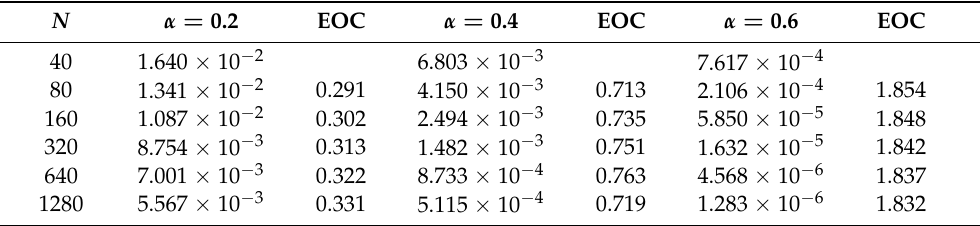
Table 11. Table showing the maximum absolute error and EOC for solving (27) using the trapezoidal method on a uniform